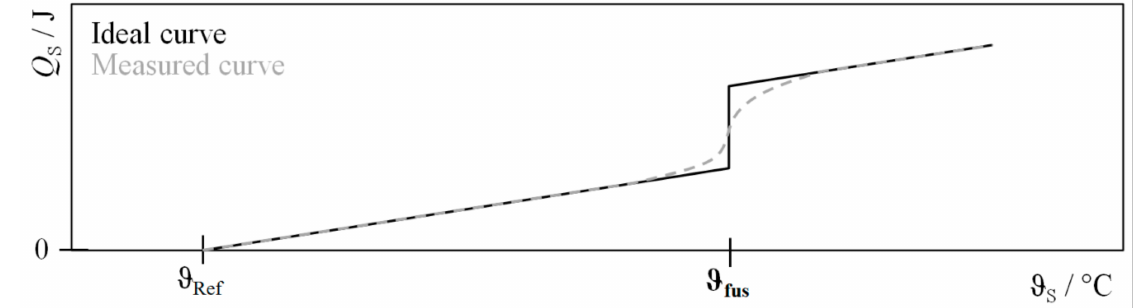
Figure 2. Ideal (solid) and measured (broken) curve of Q S over ϑ S of sample with first-order phase transition.